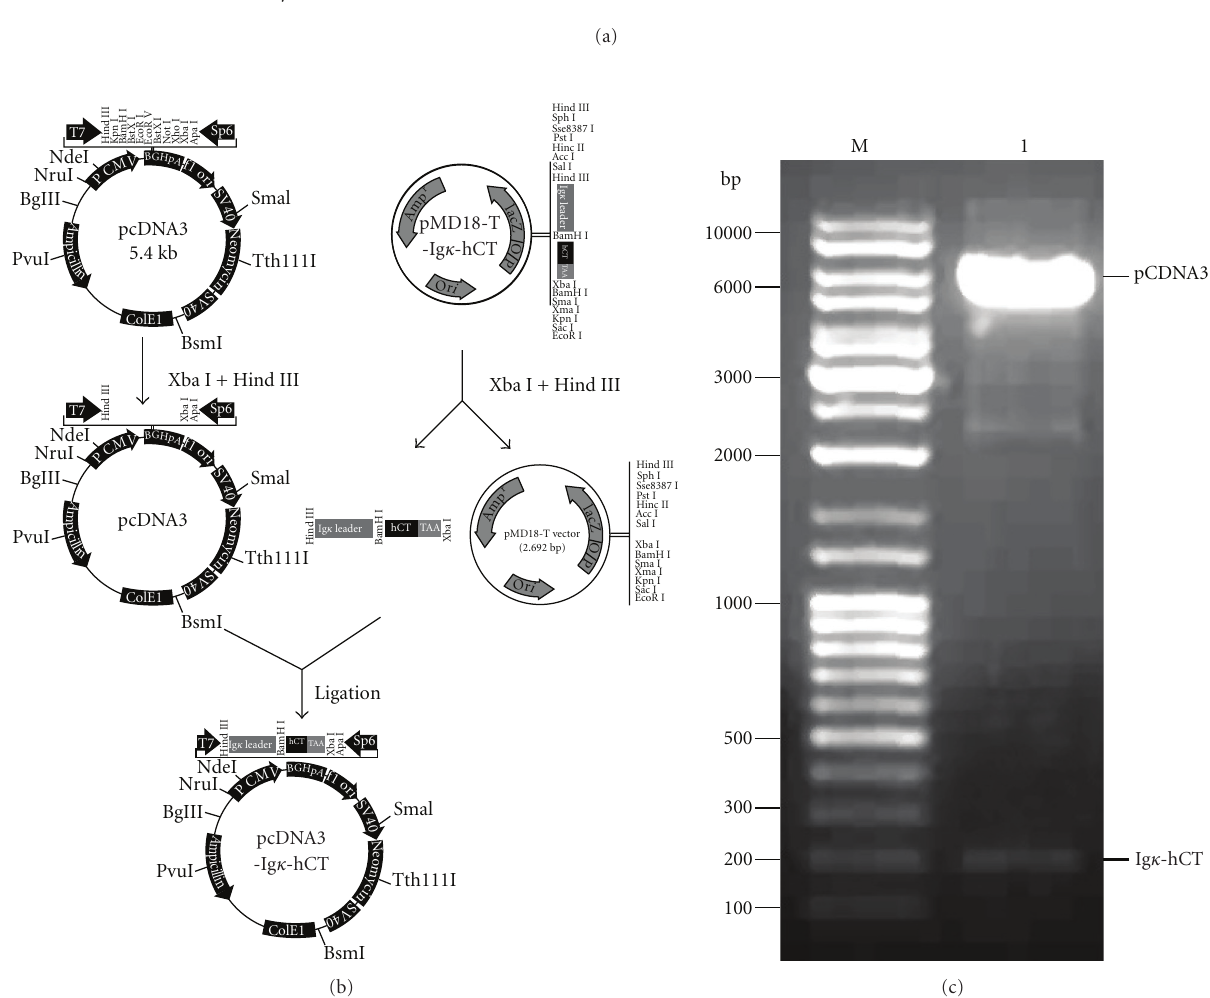
Figure 1: Construction and identification of recombinant pCDNA3.0-Ig κ -hCT eukaryotic expression vector . (a), The sequences that need to be synthesized. The recognition sequences for Hind III, BamH I and Xba I restriction enzymes are shown underline. The stop codon is shown asterisk under it. The DNA sequence of hCT is shown in boldface and italics, and the translated amino acids are under it. (b), Construction procedures of the recombinant pCDNA3.0-Ig κ -hCT eukaryotic expression vector. (c), Electrophoresis of recombinant plasmid pCDNA3.0- Ig κ -hCT digested with Hind III and Xba